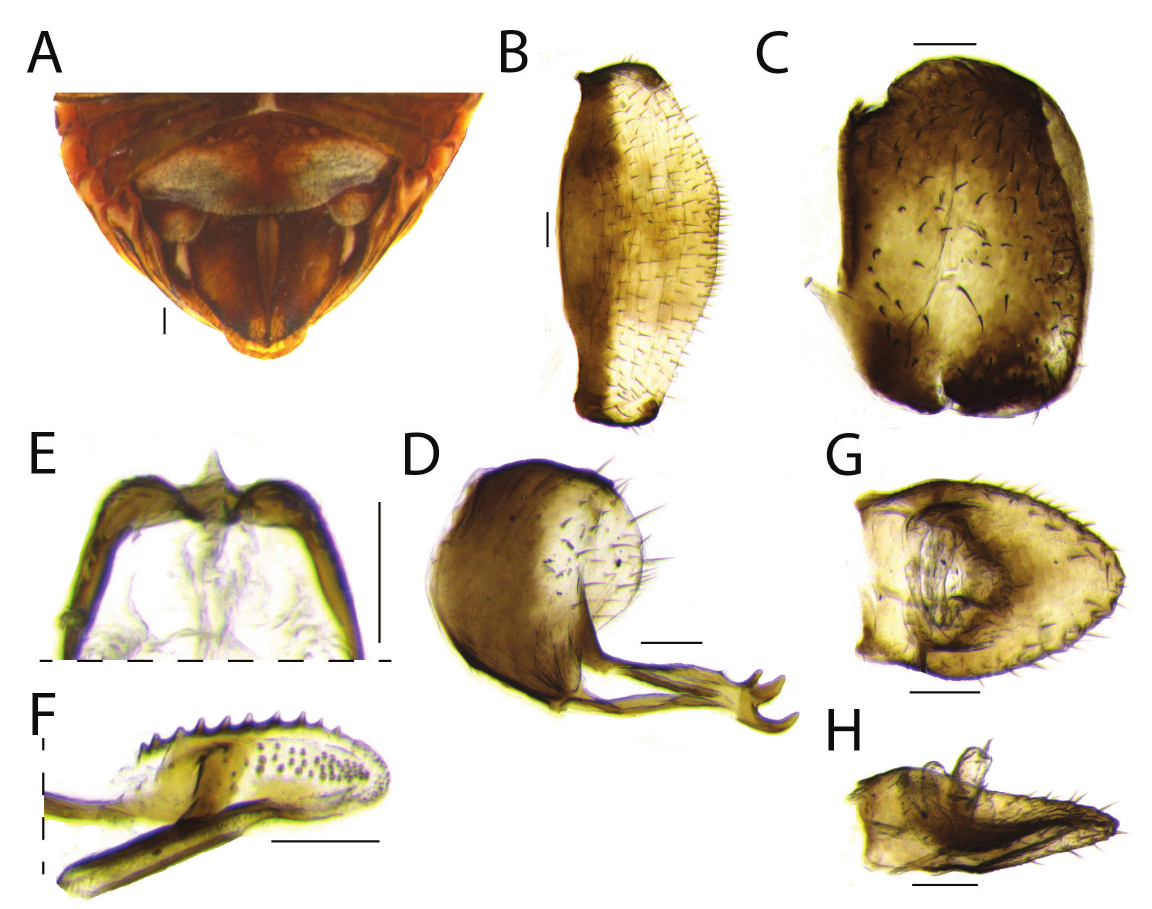
Fig. 10. Female terminalia of Bruchomorpha pseudodorsata sp. nov., holotype (INHS). A . External female terminalia, ventral view. B . Sternite VII, ventral view. C . Gonoplac, lateral view. D . Anterior connective